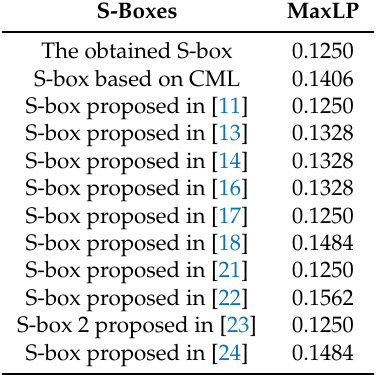
Table 11. The Linear approximation Probability (LP) analysis of different